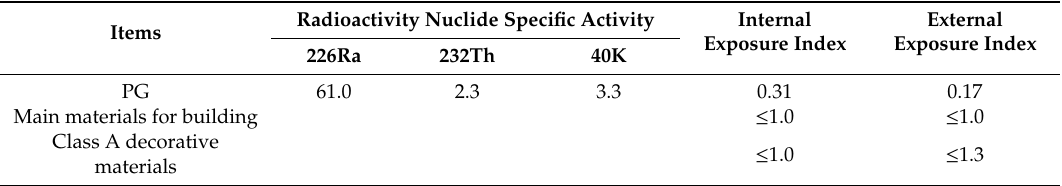
Table 1. Radioactivity of phosphogypsum